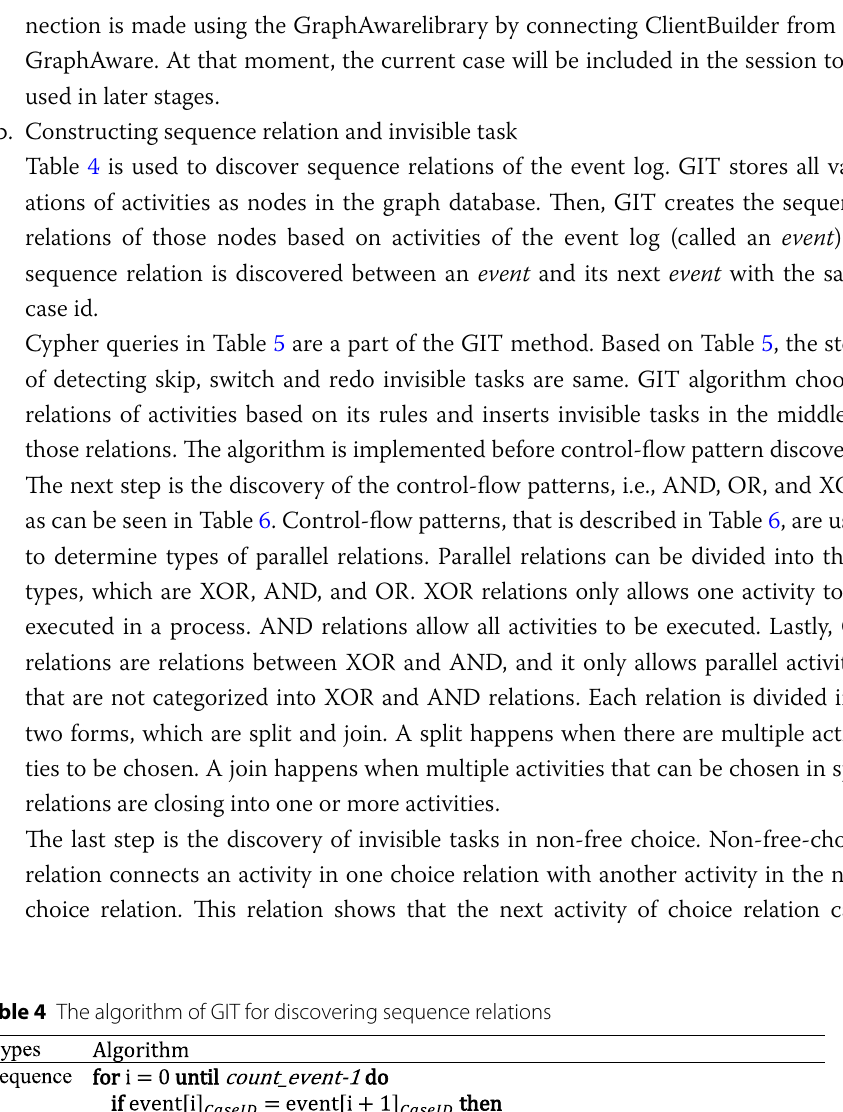
Table 4 The algorithm of GIT for discovering sequence relations